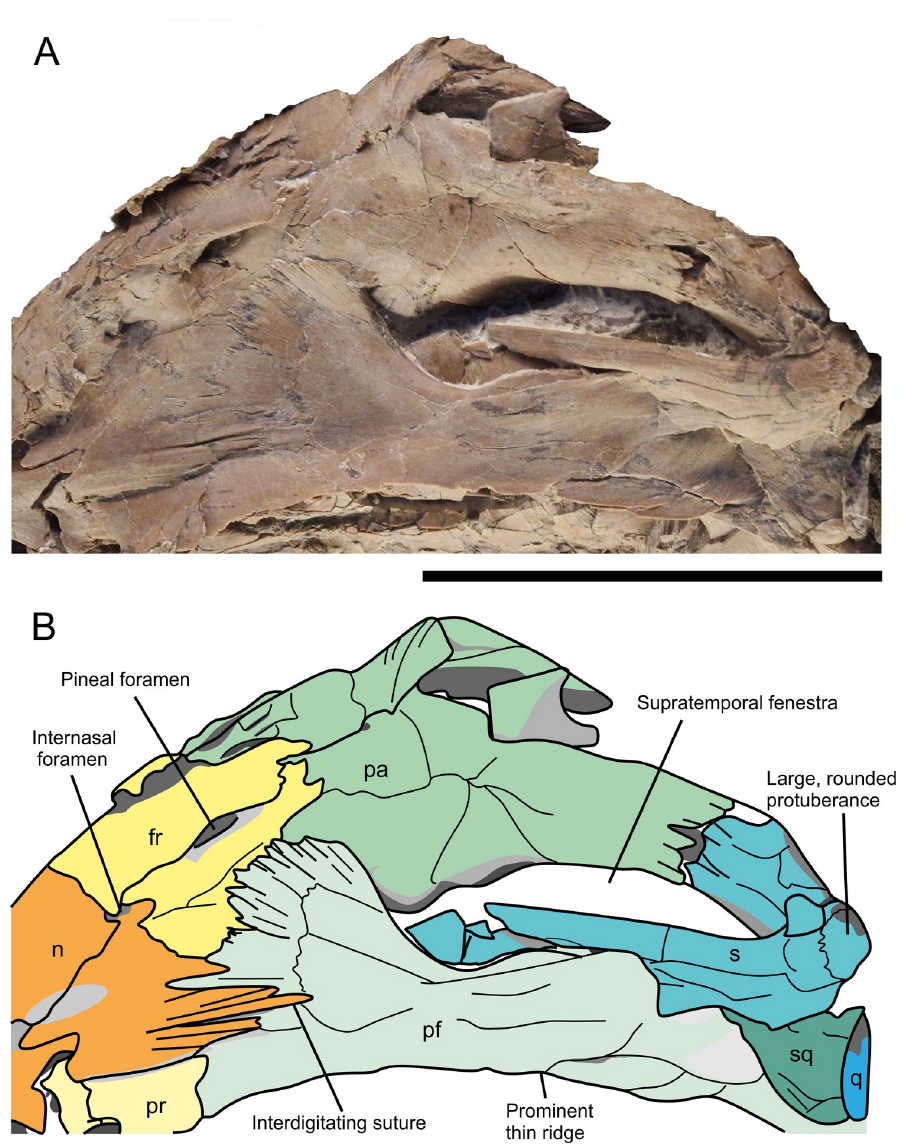
Fig 10. Dorsal portion of the skull of Thalassodraco etchesi MJML K 1885. A, photograph of the dorsal portion of the skull. B, annotated interpretation. See caption for Fig 7 for abbreviations. Scale bar 50 mm. is a broad bone with a strongly curved lateral margin, where it forms the medial margin of the supratemporal fenestra (Fig 10). The two posterior processes of the frontals overlie the parie- tals anteromedially. There is a small articulation with the postfrontals on the dorsomedial mar- gin, distal to the frontals, with large interdigitating sutures. The supratemporal process of the parietals articulates with the medial ramus of the supratemporal with a straight suture with small interdigitations along the margins. The length of medial contact is comparatively elon- gate, and the posteromedial notch is absent (cf. Arthropterygius ). The supratemporal process is moderately long, but not as robust as in some platypterygiines. There is no evidence of orna- mentation or a sagittal crest along the dorsal surface of the skull.